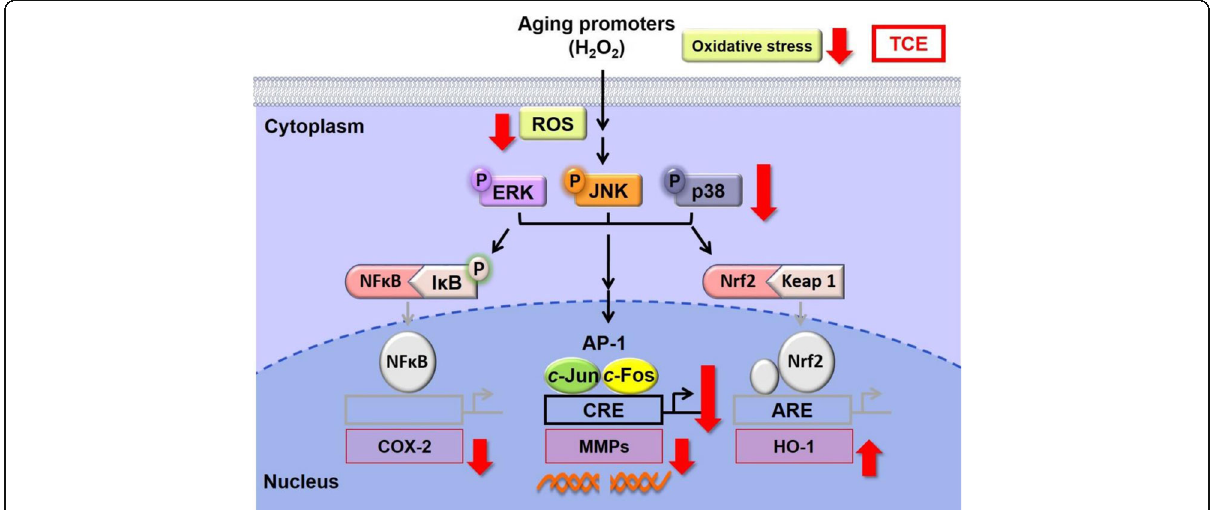
Fig. 4 Scheme for TCE inhibition of oxidative stress-induced skin damage. ( ↑ : upregulation; ↓